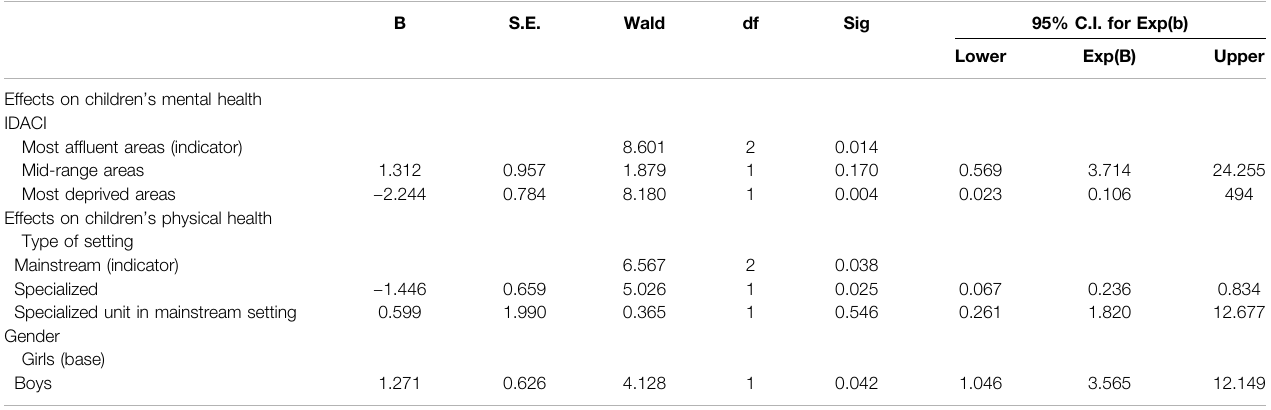
TABLE 3 | Parameter estimates for the effects of IDACI and type of setting on detrimental effect of school closures on mental and physical health, respectively. B S.E. Wald df Sig 95% C.I. for Exp(b) Lower Exp(B) Upper